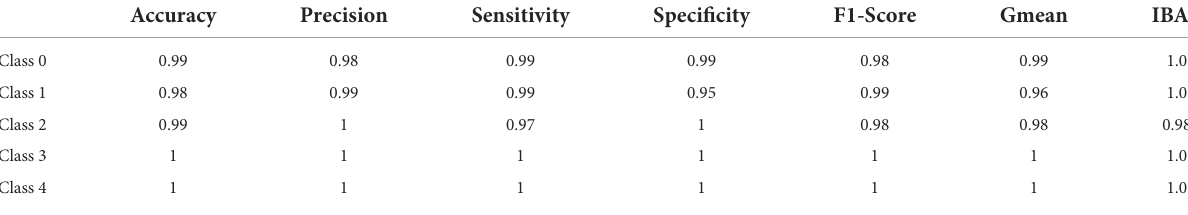
TABLE 7 Performance metrics of XGBoost classifier with random over-sampling technique.